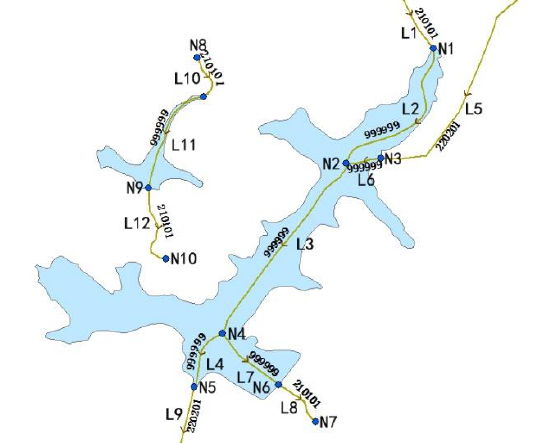
Figure 1. Classification of structural lines of hydrologic